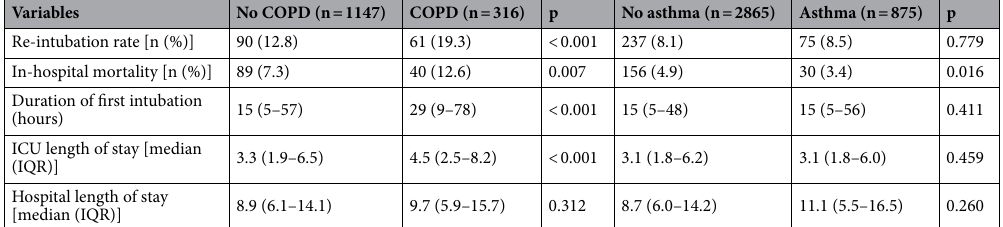
Table 4. Comparisons of clinical outcomes after propensity score matching. The following variables were selected to generate the propensity score: age, sex, hypertension, diabetes, renal replacement therapy, maximum sequential organ failure assessment score during ICU stay, duration of intubation, any vasopressor use within the first 24 h, serum creatinine level, haemoglobin level, potassium level, and sodium level. Gamma for COPD 2.1, p 0.063. COPD chronic obstructive pulmonary disease, ICU intensive care unit, IQR inter quartile range.